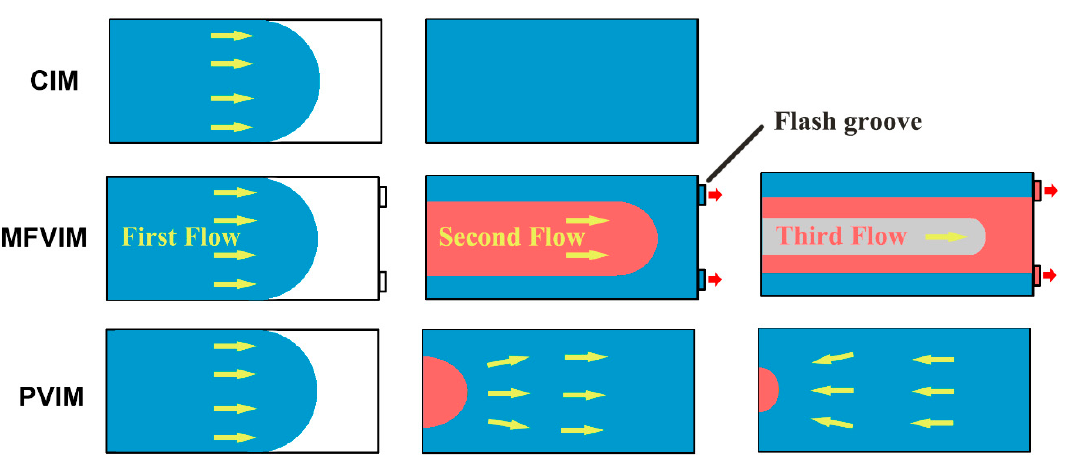
Figure 3. Schematic melt flow in di ff erent injection-molding cavities. The arrows indicate the melt-flow direction. The di ff erent colors represent the melts that enter the die at di ff erent times. Three melt flows are drawn in MFVIM.